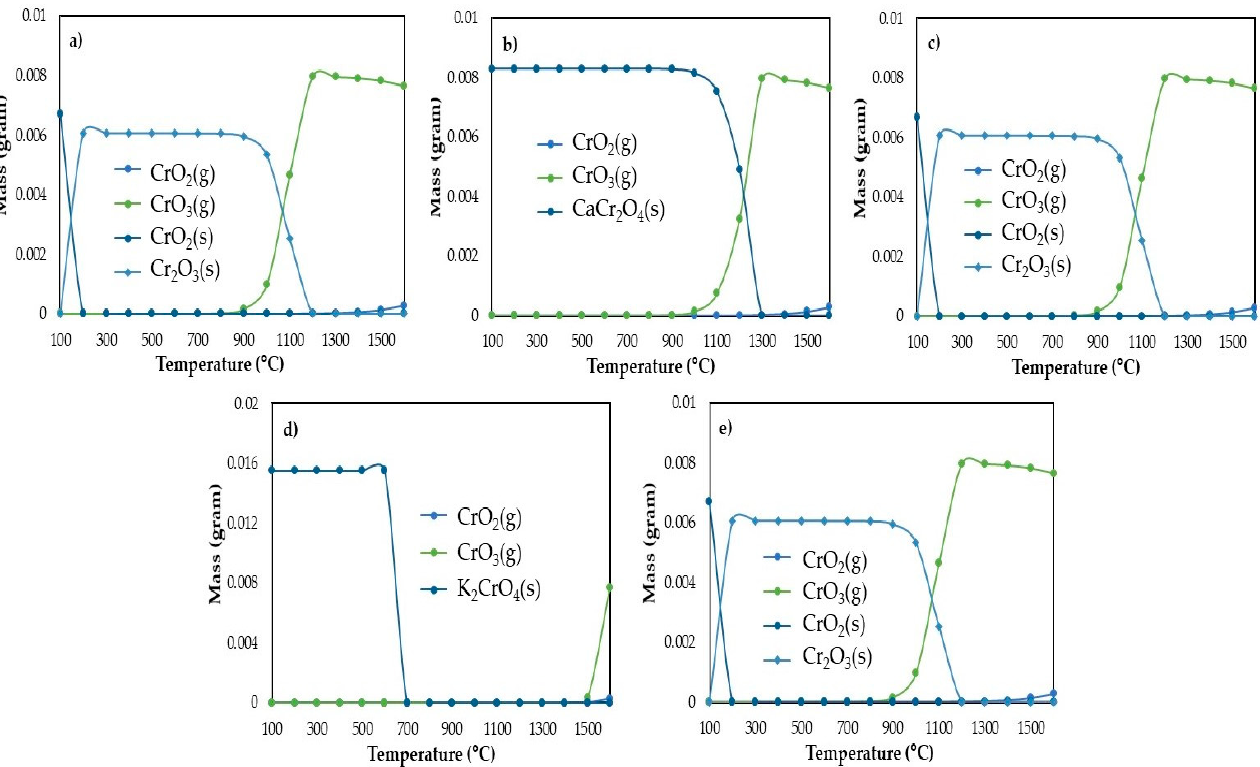
Figure 2. Equilibrium composition of B-Mineral oxides interactions during combustion: ( a ) B-O 2 -Al 2 O 3 ; ( b ) B-O 2 -CaO; ( c )